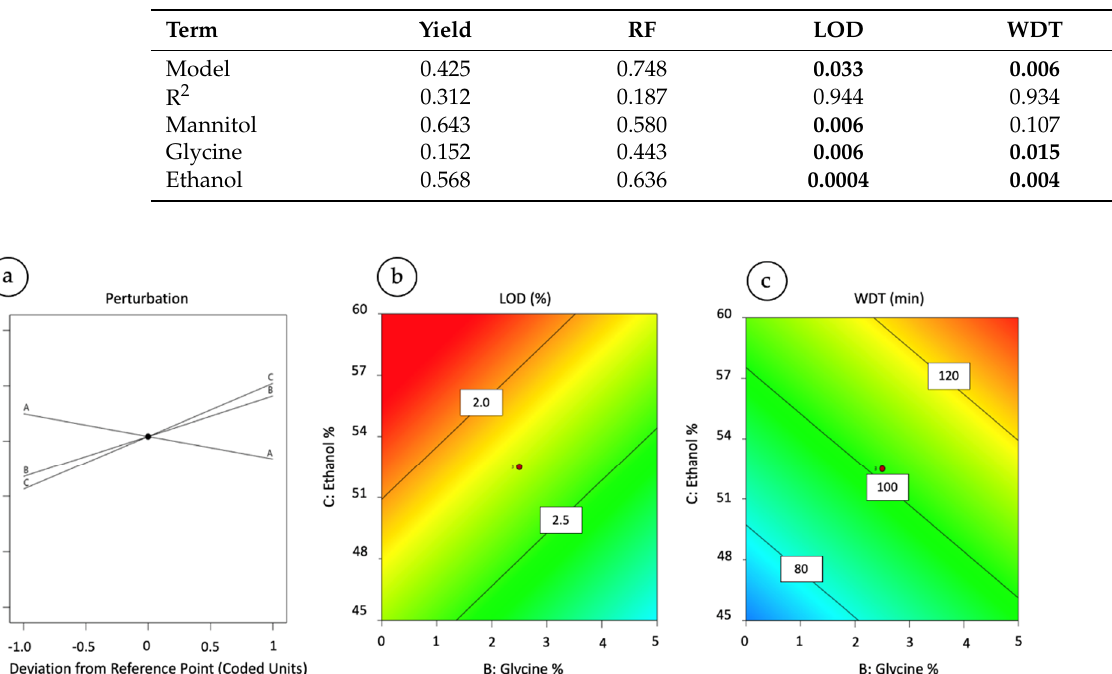
Table 3. Probability values for the model terms relating to selected CQAs. RF = respirable fraction; LOD = loss on drying; WDT = Weibull dissolution time. The model was significant at p < 0.05 and highlighted in bold.